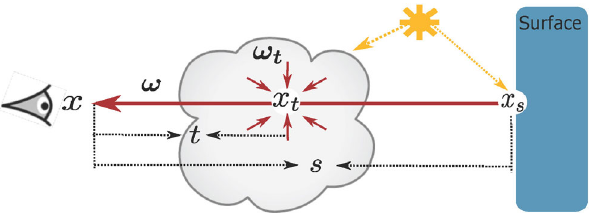
Fig. 1 Light transport in participating media. Symbols are defined in Eq.